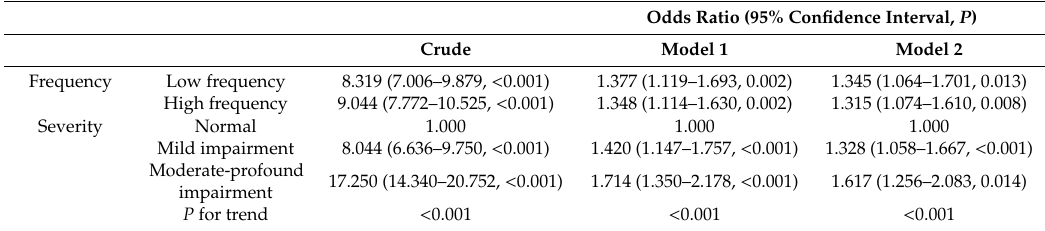
Table 5. Weighted ORs for cataract according to impaired frequency and the severity of hearing impairment.